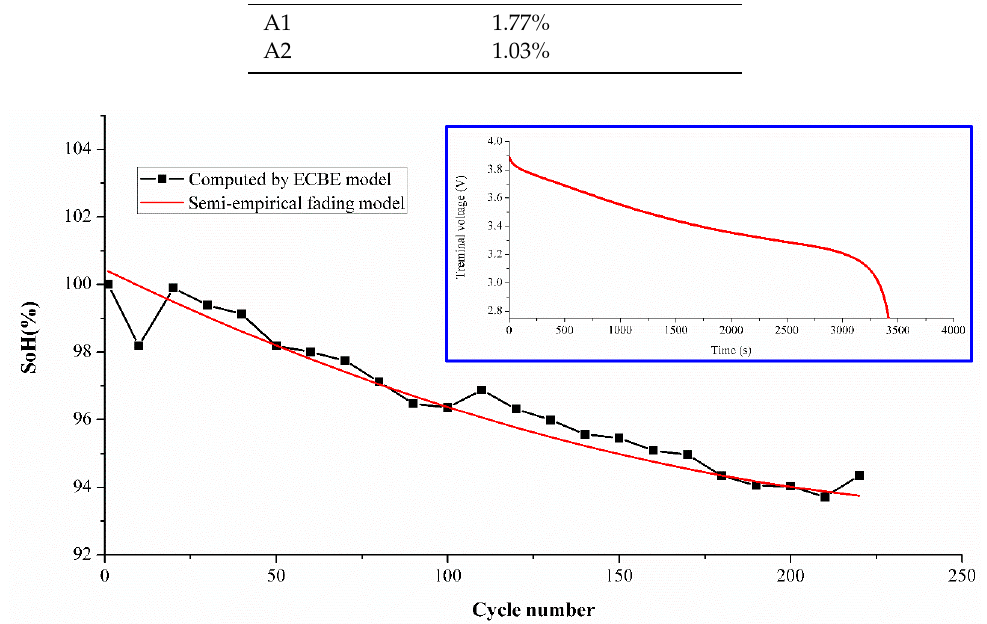
Figure 9. SoH estimation curve for Lithium Cobalt Oxide (LCO) cell to compare the di ff erence between experimental SoH and estimated SoH. Inset graph shows the discharge curve of LCO